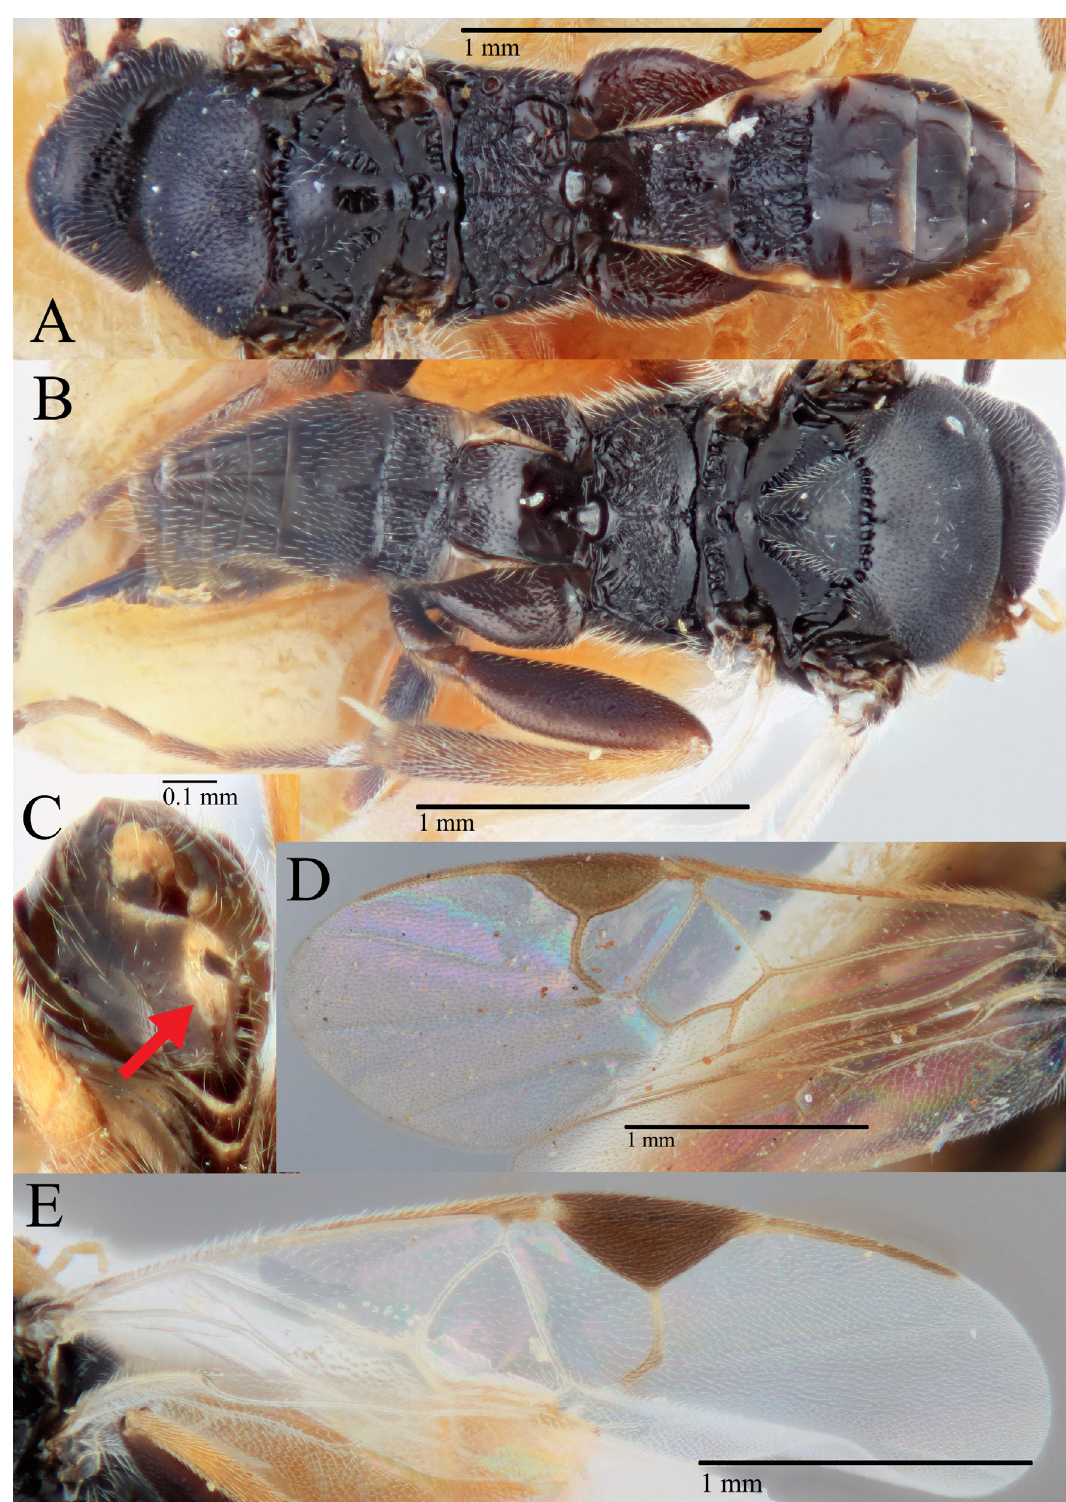
Fig. 18. A . Cotesia glomerata (Linnaeus, 1758), specimen from South Perth (WINC), habitus in dorsal view. B . C. kazak (Telenga, 1949), specimen from Mariginiup (WINC), habitus in dorsal view. C . C. glomerata , specimen from Victoria (WINC), hypopygium in ventral view, arrow pointing towards emarginated area. D . C. glomerata , fore wing. E . C. kazak , fore